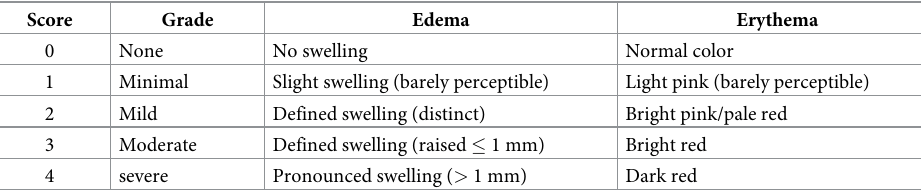
Table 2. Adapted Draize